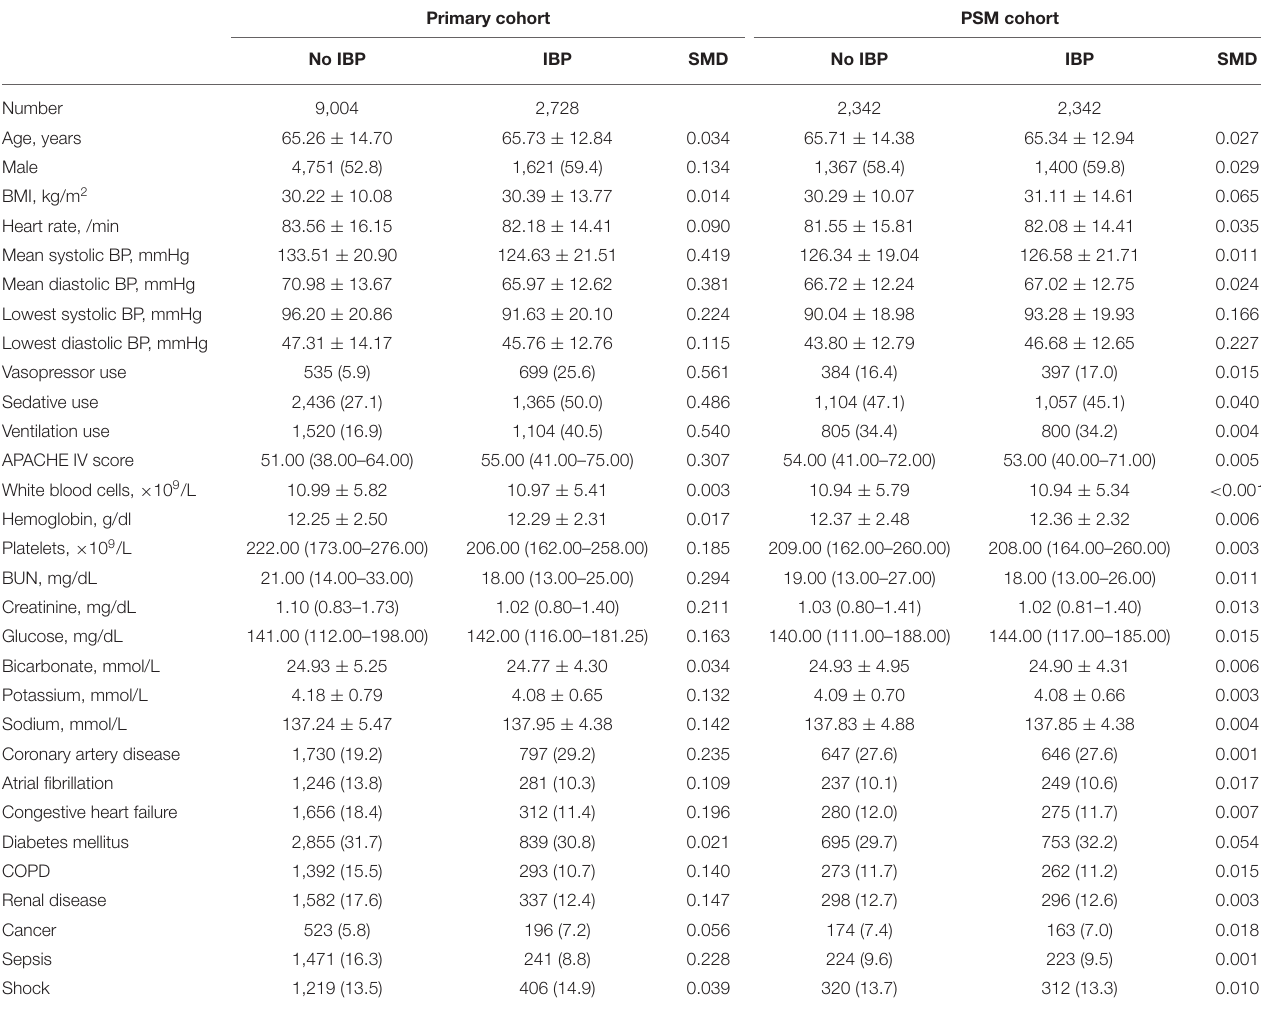
TABLE 1 | Baseline characteristics of subjects in the primary and PSM